Question: Summarize what this figure shows in one sentence.
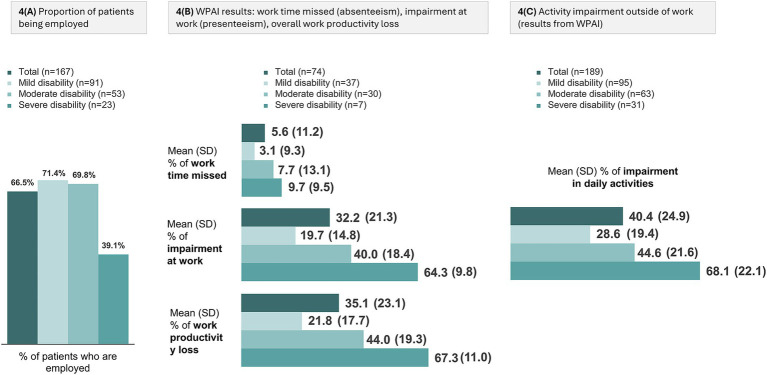
Answer: Employment rate and WPAI outcomes. (A) Percentage of patients who are employed, (B) Work productivity among patients who are employed, (C) Daily activity impairment. n: sample size; SD: standard deviation.